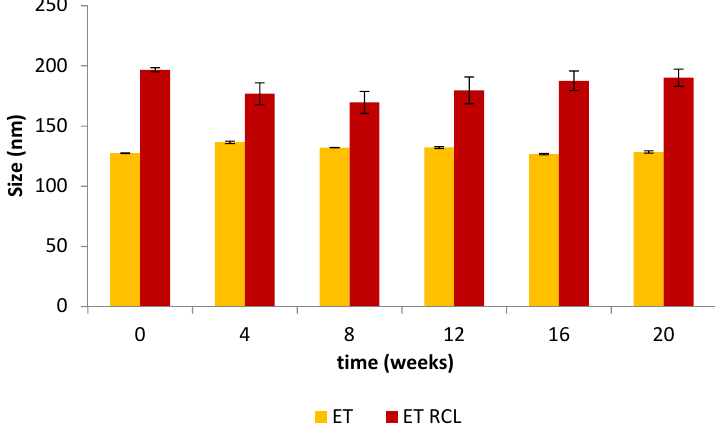
Figure 3. Size of unloaded (ET) and loaded ethosomes (ET RCL) during 20 weeks of storage at 4.0 ± 1.0 °C .